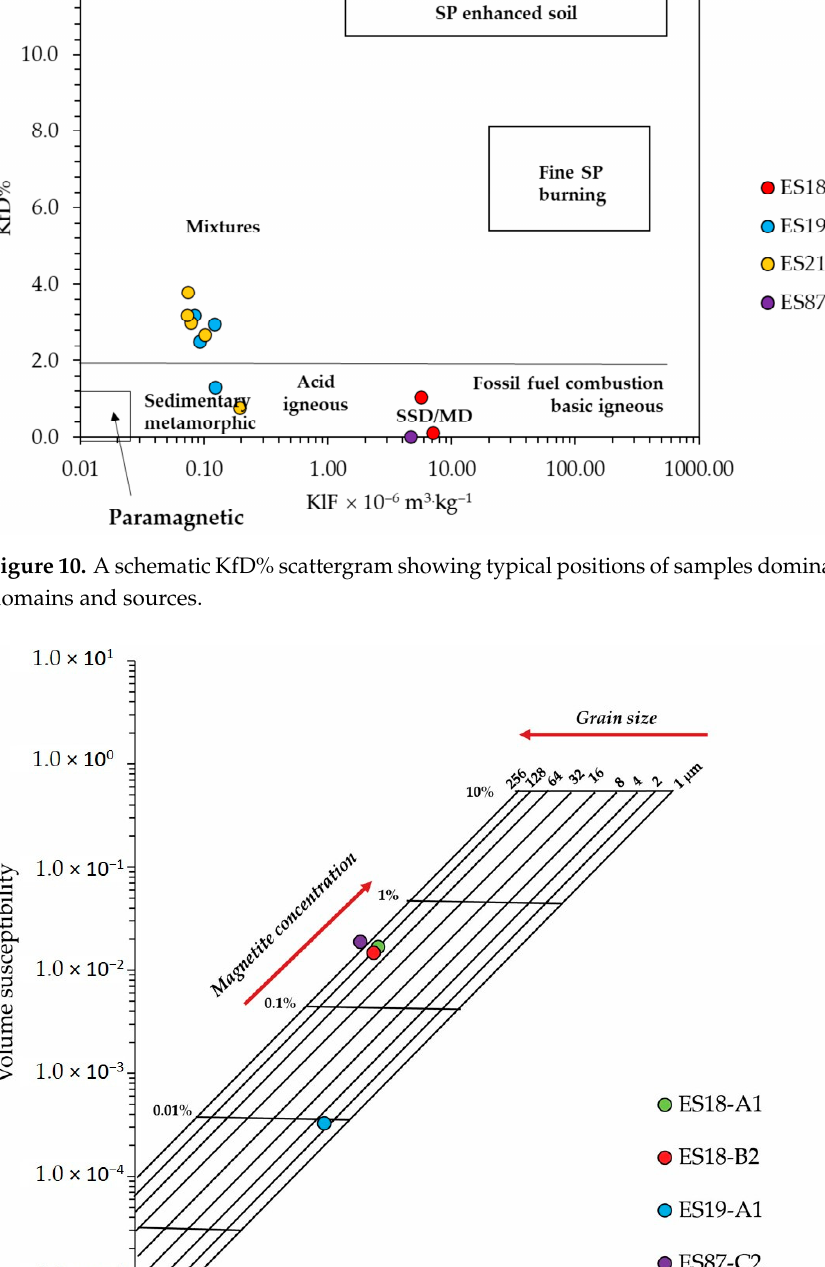
Figure 10. A schematic KfD % scattergram showing typical positions of samples dominated by various domains and sources.